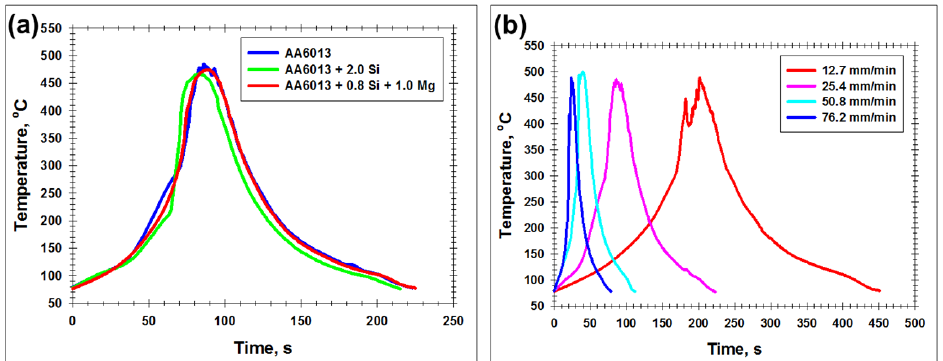
Figure 3. Typical effect of the alloying composition of aluminum alloy ( a ) and welding speed ( b ) on FSW thermal cycle. In ( a ), FSW was conducted at welding speed of 25.4 mm/min. In ( b ), temperature data for AA6013 alloy are shown.